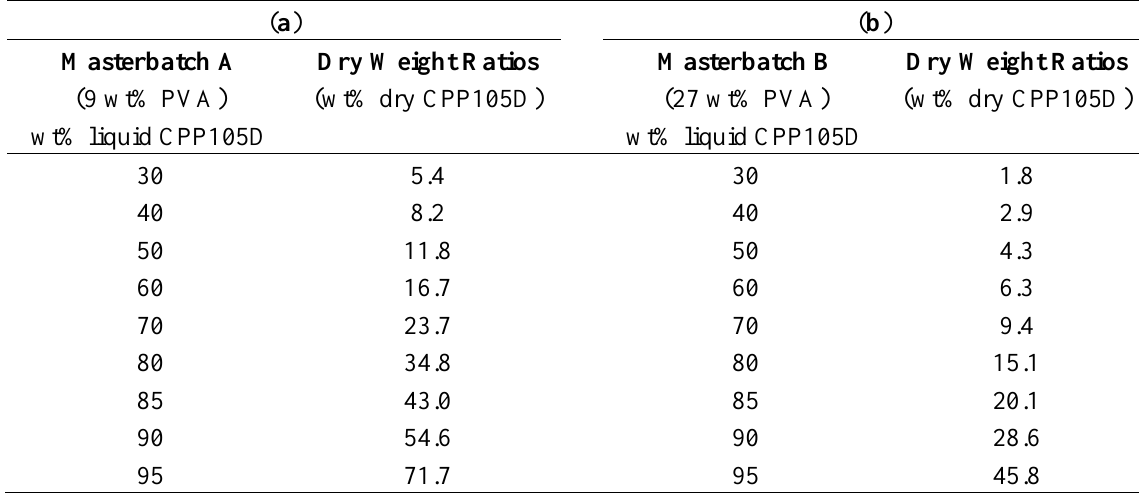
Table 2. ( a ) and ( b ) Dry mass weight ratios of Clevios™ CPP105D to PVA from masterbatches A and B,